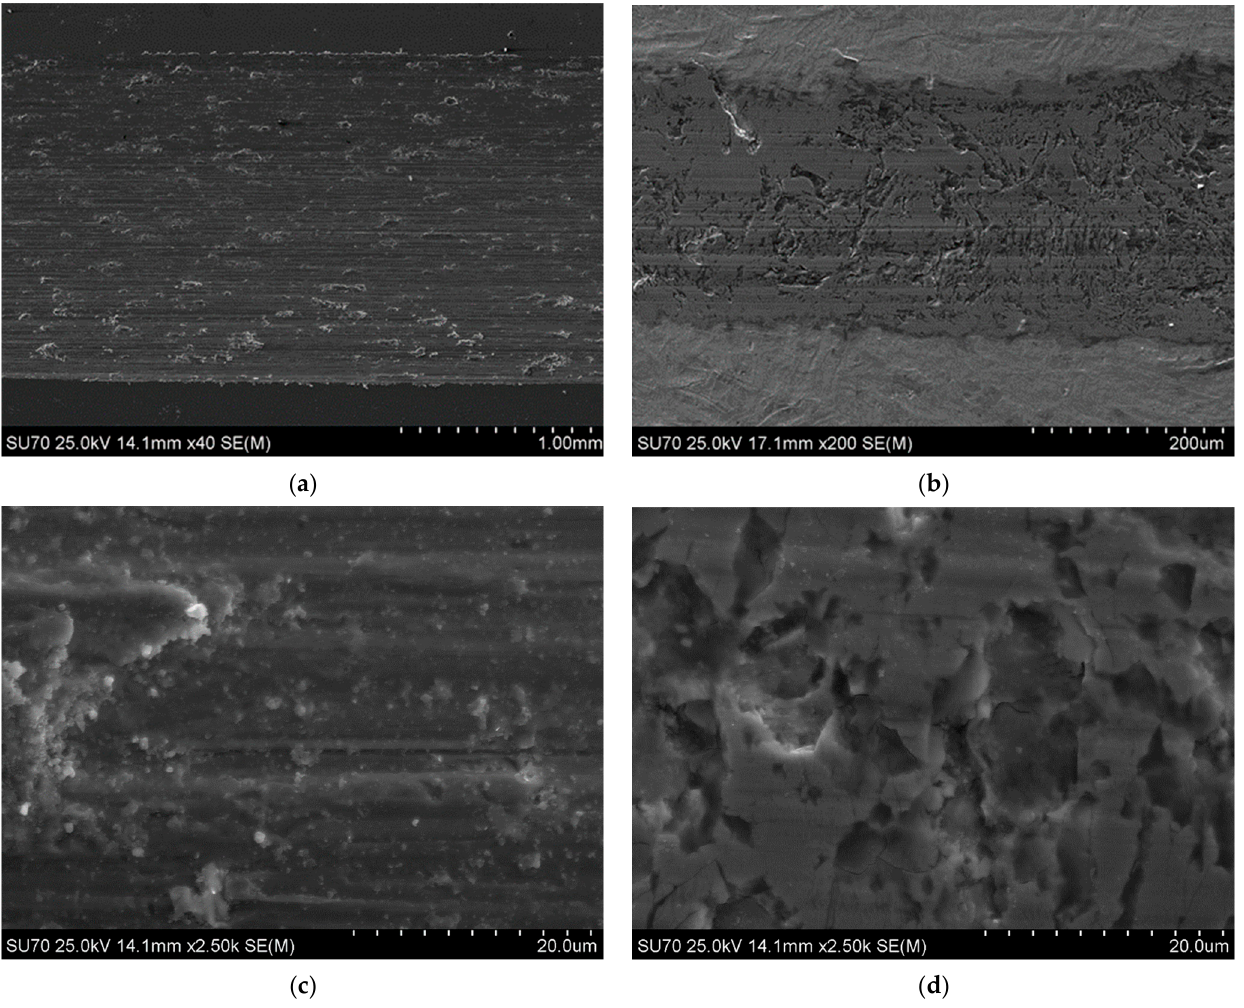
Figure 9. Secondary electron images of the surface of wear tracks after tribological tests of: ( a , c ) Nanoflex steel in condition C, ( b , d ) layers nitrided at a temperature 450 °C for 4 h in an atmosphere containing 100% NH 3 .